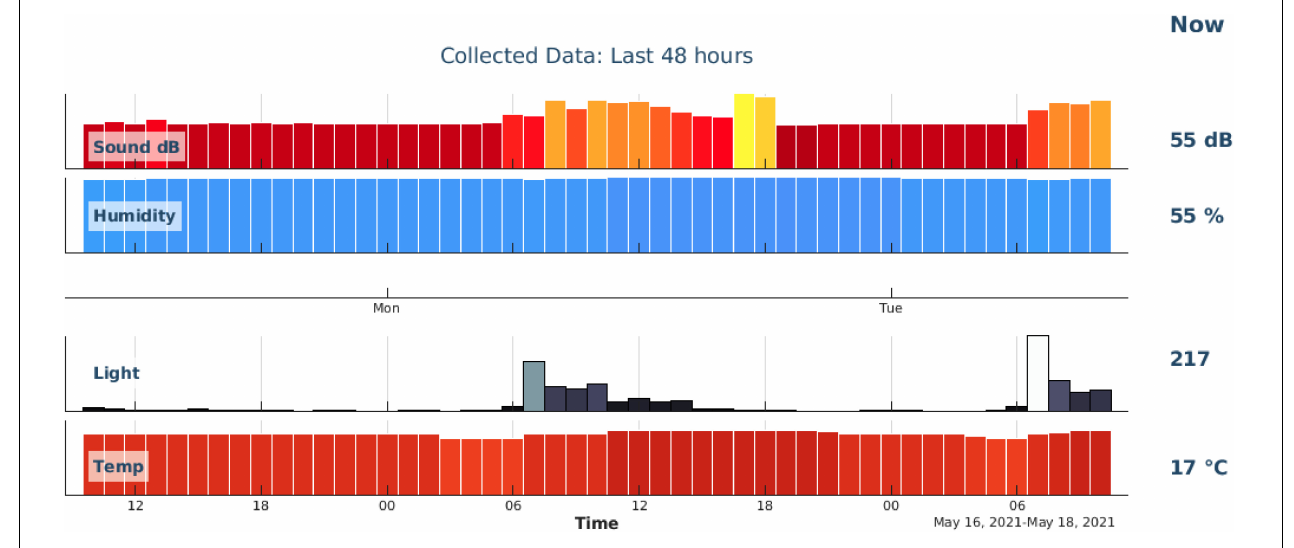
FIGURE 5 | Chart displaying information for the previous 48 h.